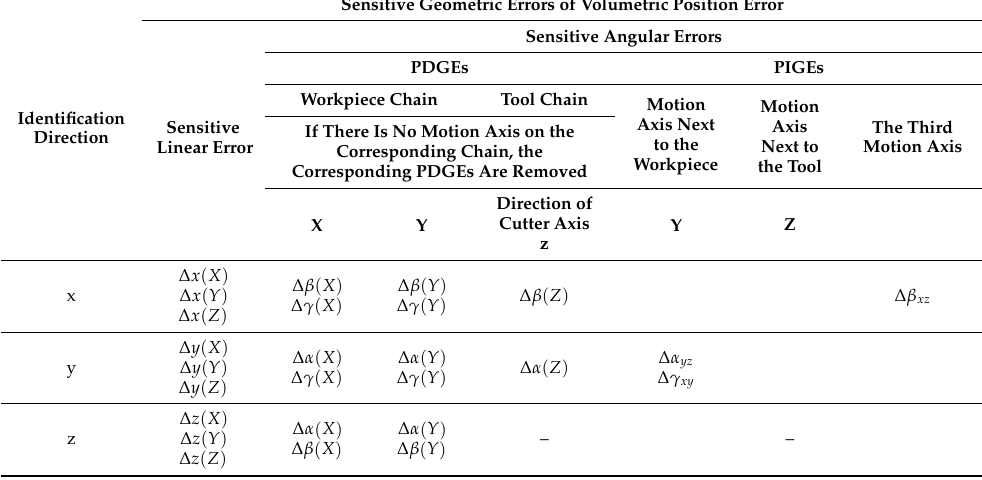
Table 4. Sensitive geometric errors of volumetric position error of structure shown in Figure 9 based on Table 2.